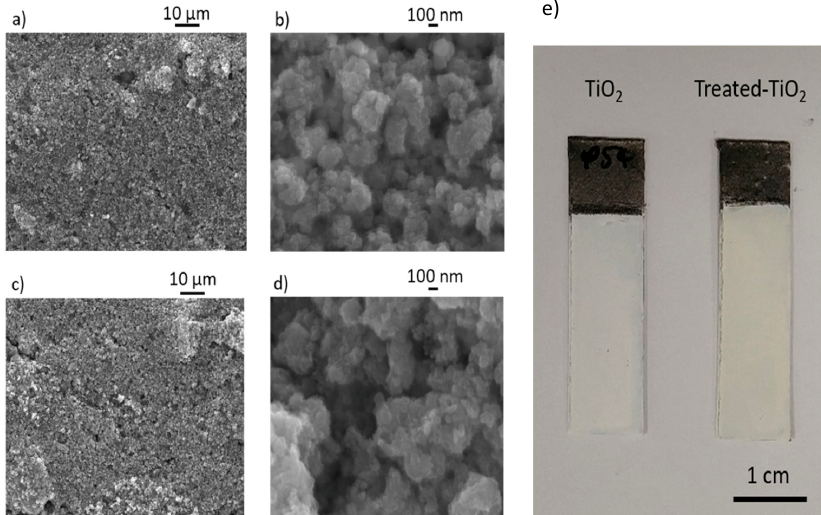
Figure 2. ( a , b ) present SEM images of a TiO 2 electrode at 1000× and 4,0000× magnification; ( c , d ) show images from a treated-TiO 2 electrode. ( e ) shows a photographic image of a TiO 2 (left) and treated-TiO 2 (right) electrode.